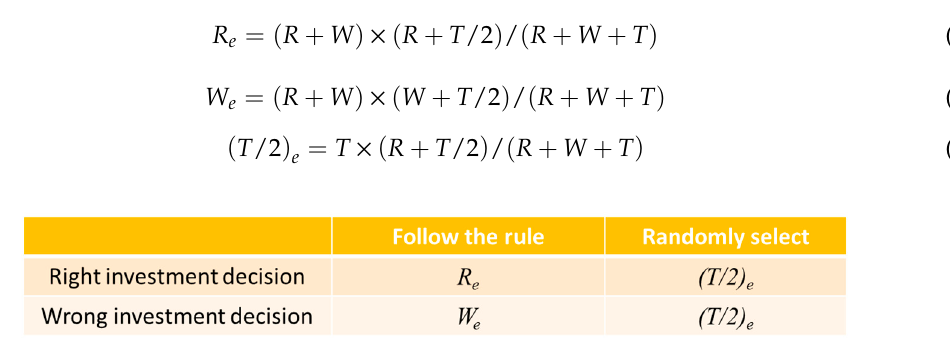
Figure 4. Expected frequencies: f e.